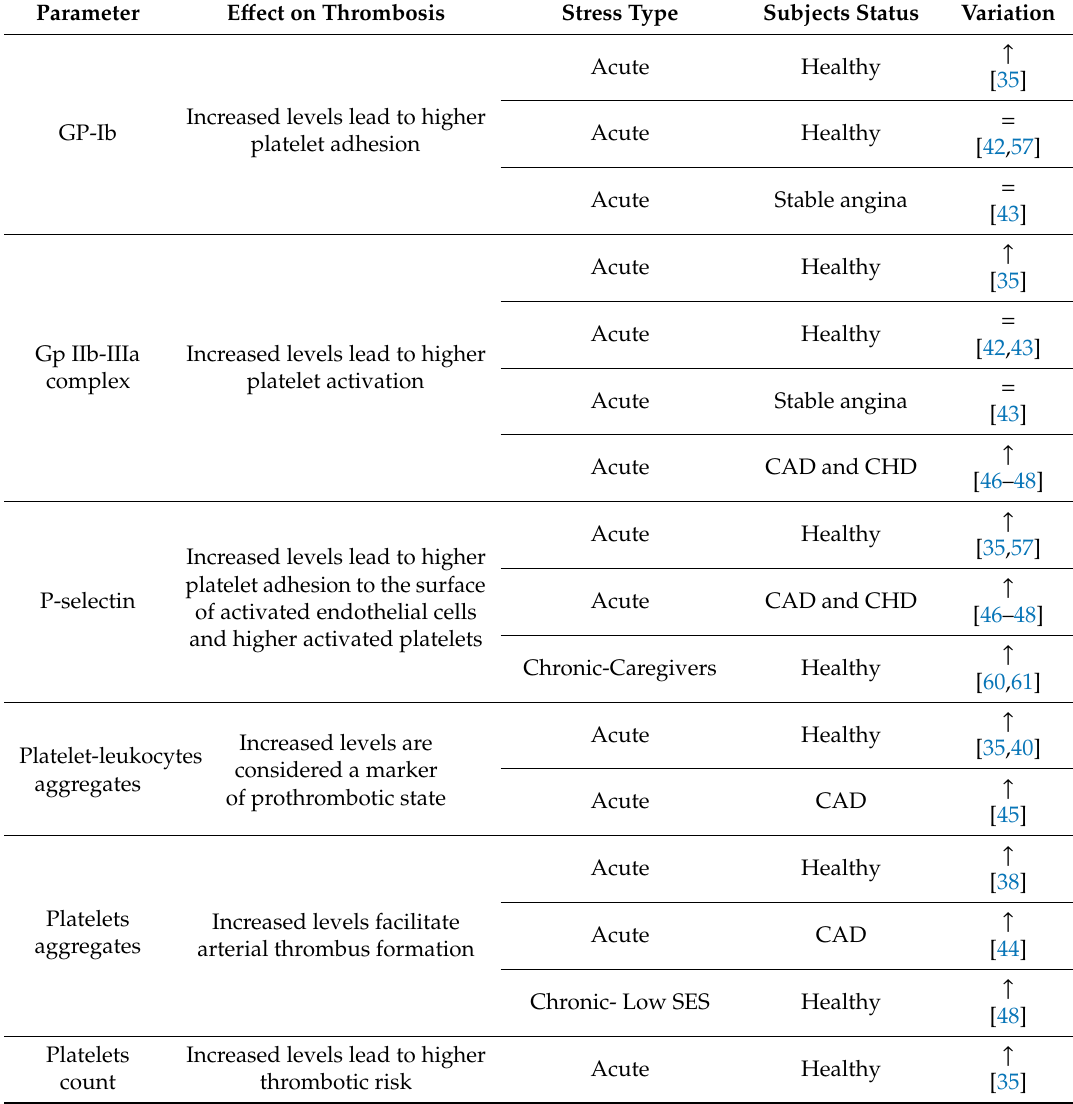
Table 1. Alteration of platelets according to stress type and subjects’